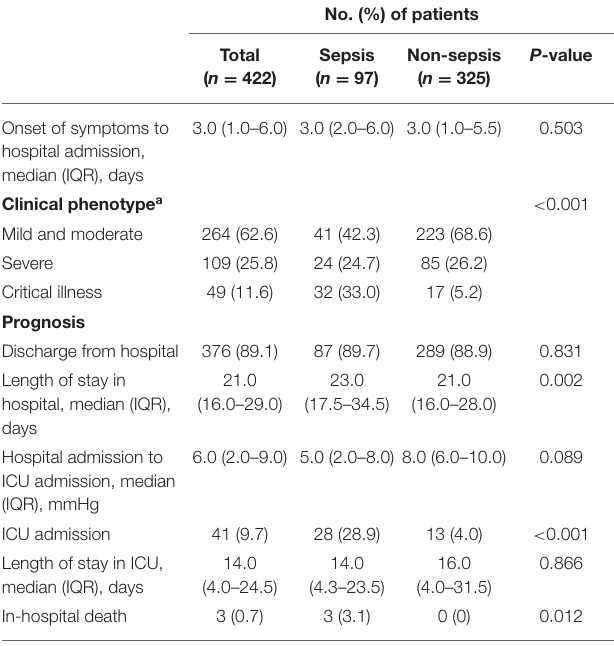
TABLE 1 | Baseline characteristics of 422 patients confirmed with COVID-19 in Shenzhen, China.